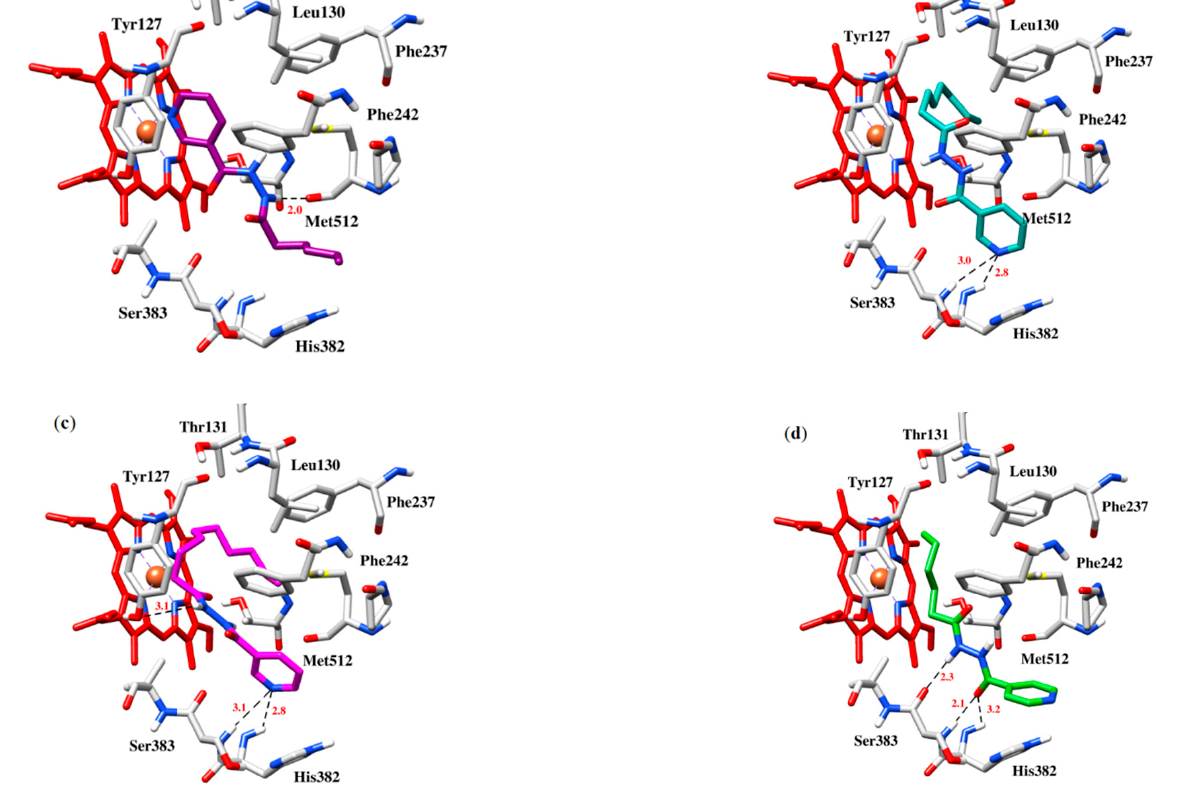
Figure 11. Binding pose of 4 with the antibacterial target protein (light grey) topoisomerase IV. The dashed black line depicts hydrogen bond interaction.